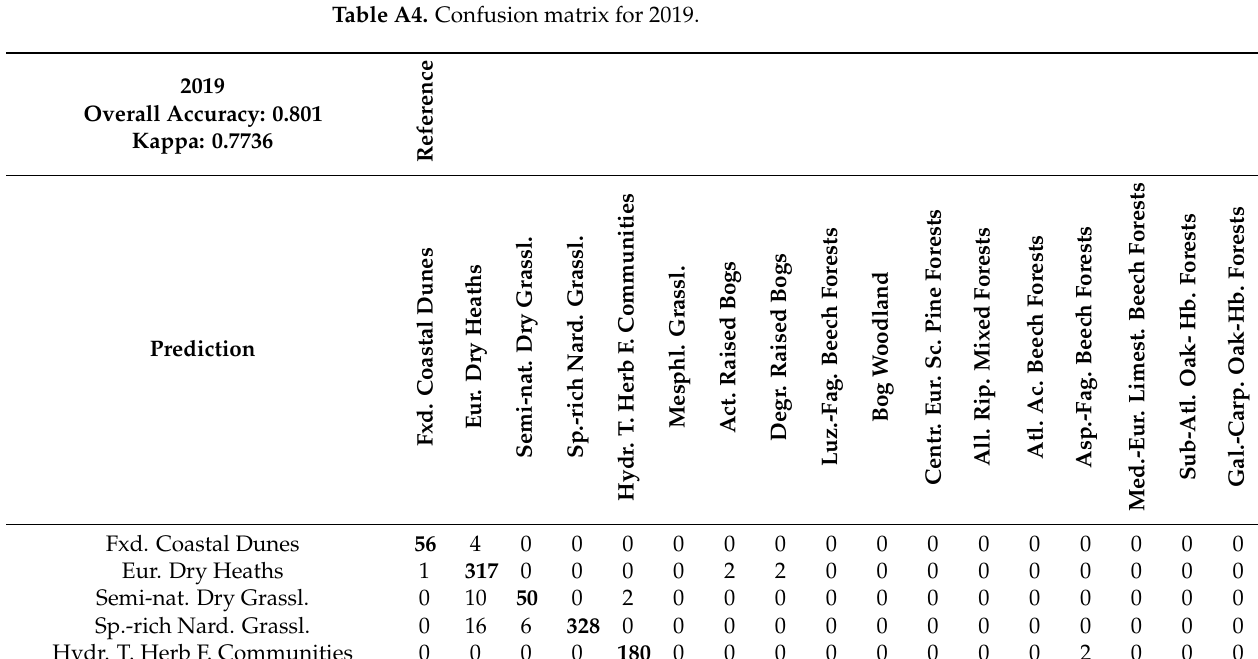
Table A4. Confusion matrix for